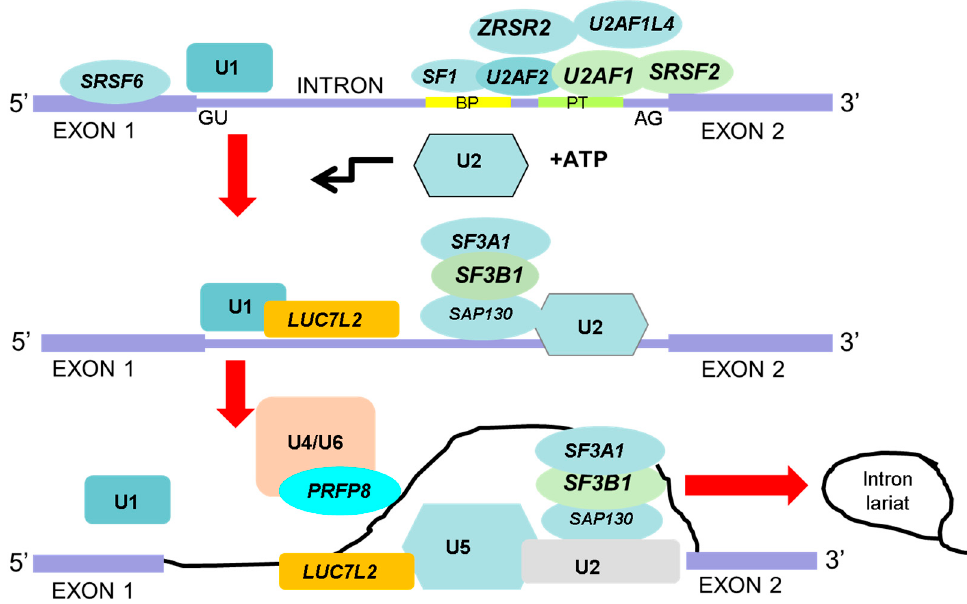
Figure 1. Spliceosome complex. Pre-mRNA splicing initiates with the recruitment of U1 snRNP to the 5 ′ splice site (SS). Serine-arginine rich (SR) proteins such as SRSF6 are localized nearby the 5 ′ SS regulating alternative splicing. The SF1 protein and the larger subunit of the U2 auxiliary factor (U2AF), U2AF2, both gather to bind the branch point (BP) sequence and the polypyrimidine tract (PT). The smaller subunit of U2AF (U2AF1) binds to the AG dinucleotide of the 3 ′ SS, interacting with both U2AF2 and the splicing factor SRSF2. ZRSR2 and U2AF1L4 (other two RNA-binding proteins) are recruited to interact with U2AF complex (U2AF1 and U2AF2) in order to recognize the 3 ′ SS. After the recognition of the 3 ′ SS, the U2 snRNP, together with SF3A1, SF3B1, and SAP130*, is recruited to the 3 ′ SS. In the meantime, the U1 and LUC7L2 are recruited to the 5 ′ SS and the U4/U6 and U5 complex, together with PRFP8, localize on the BP and PT regions to catalyze the release of the intron lariat and ligation of exons. *SAP130: Official gene name is SF3B3 .